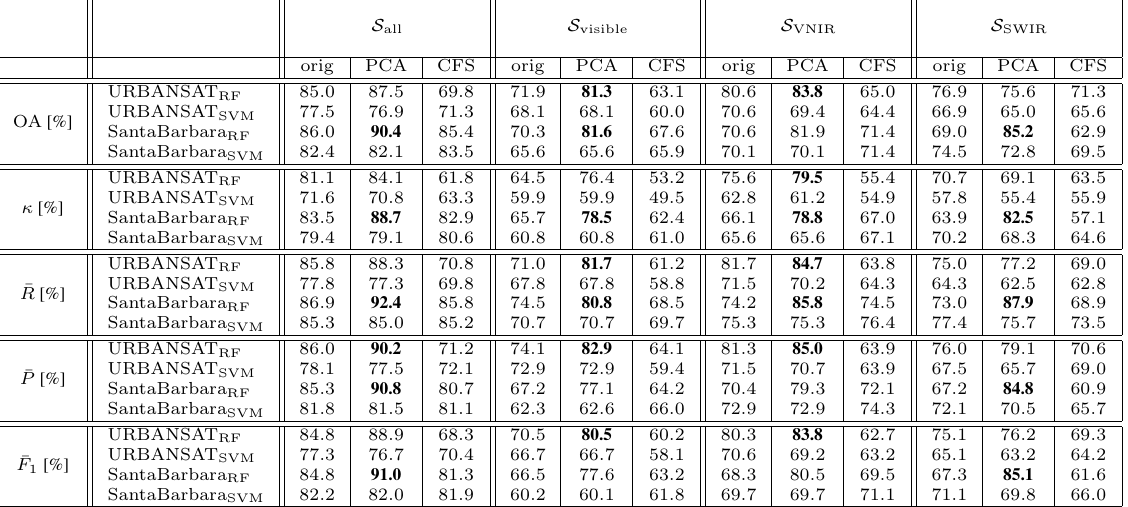
Table 1. Classification results achieved for the two